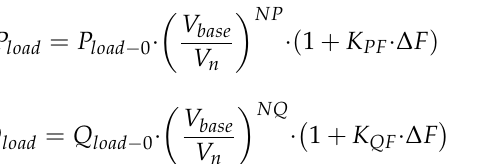
Table 4. Parameters for the considered case